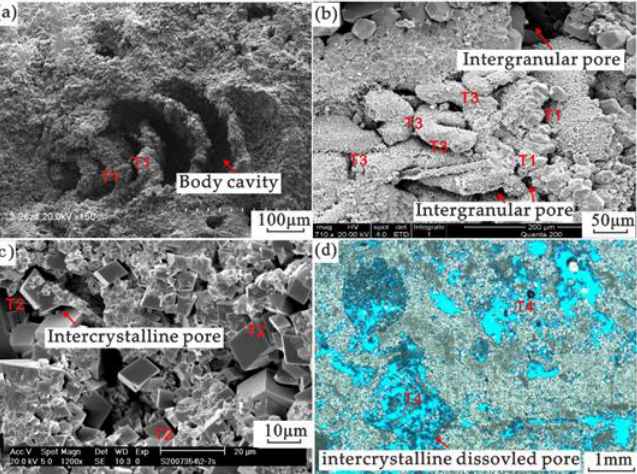
Figure 6. Types and characteristics of different throats in North Truva Oilfield ( a ) Well 5555, 2335.24 m, with residual foraminiferal micrite dolomite, developed with body cavity pores, intercrystalline (dissolved) pores and intercrystalline micropores, among which the body cavity pores are connected by a pore-reduced throat (T1); ( b ) Well A-5, 2758.2 m, sparite bioclastic limestone with algae mass, mainly intergranular pores and intercrystalline pores, developed with tubular throats (T3) and pore-reduced throats (T1); ( c ) Well CT-4, 2325.37 m, bioclastic micrite dolomite with intercrystalline pores and lamellar throats (T2); and ( d ) Well 5555, 2331.66 m, residual foraminiferal powder crystal dolomite, intercrystalline dissolved pores, mold pores and various dissolved pores are very developed but unevenly distributed, strongly dissolved and is in the shape of carbon-slag in some parts, with primarily network throats (T4) and sheet throats (T2), with good connectivity.